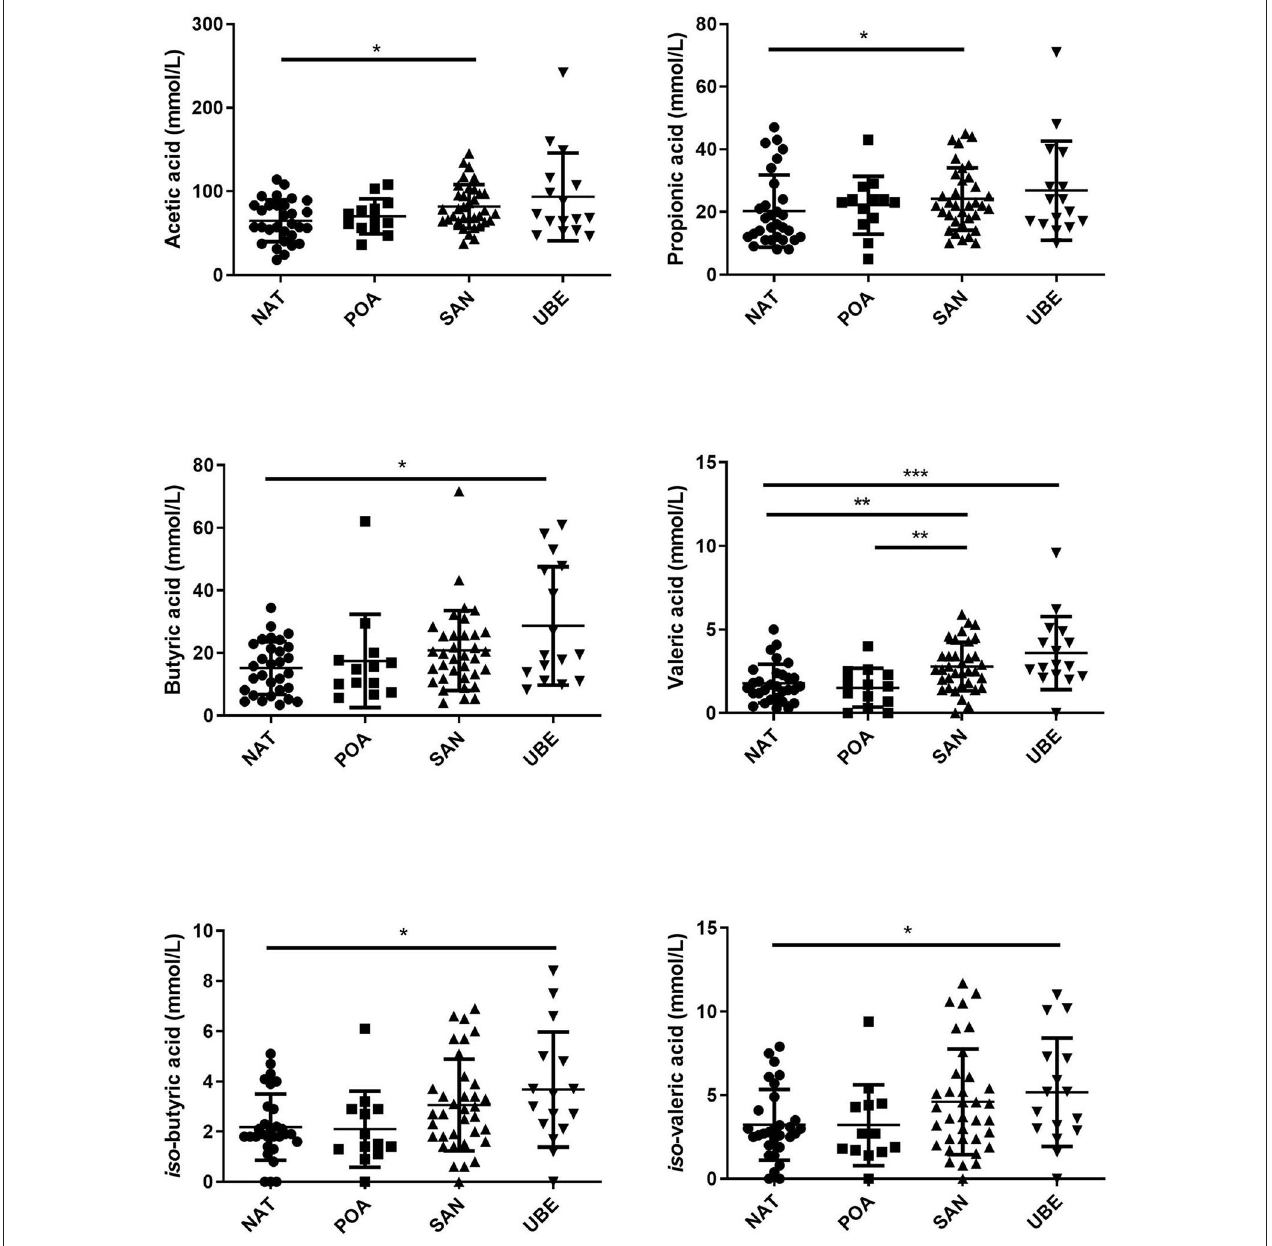
FIGURE 6 | Comparison of short-chain fatty acids (SCFAs) across the geographical locations indicates that subject variation contributes to the significant differences observed in the different fatty acids. Where * p < 0.05, ** p < 0.005, *** p < 0.0005.